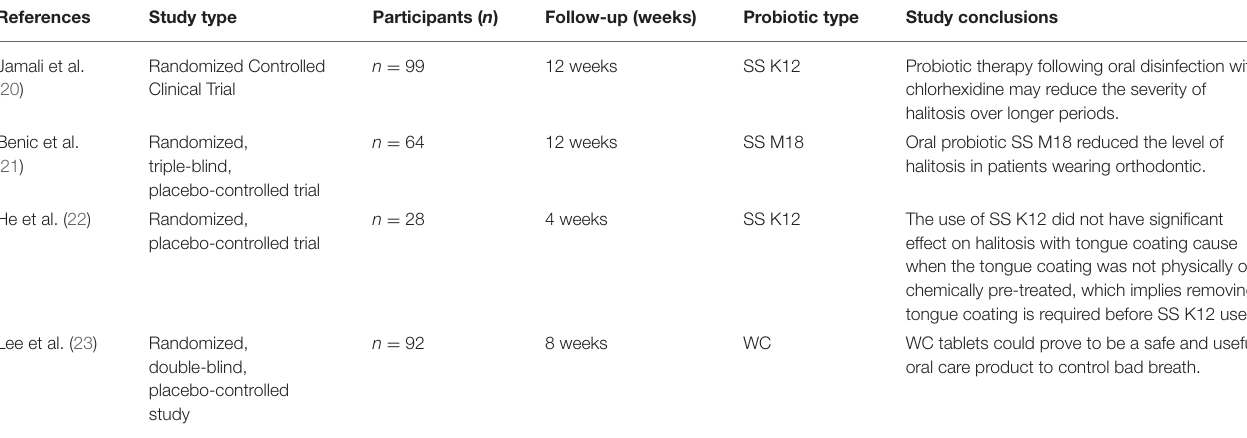
TABLE 1 | General characteristics of studies.